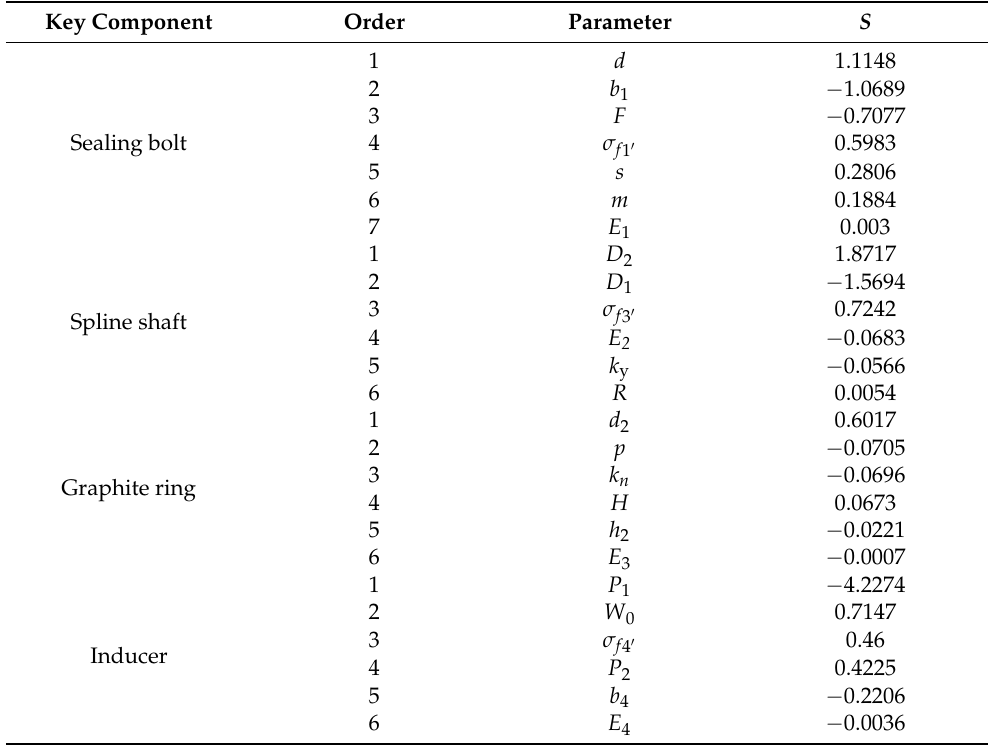
Table 8. The results of the sensitivity analysis of the four key